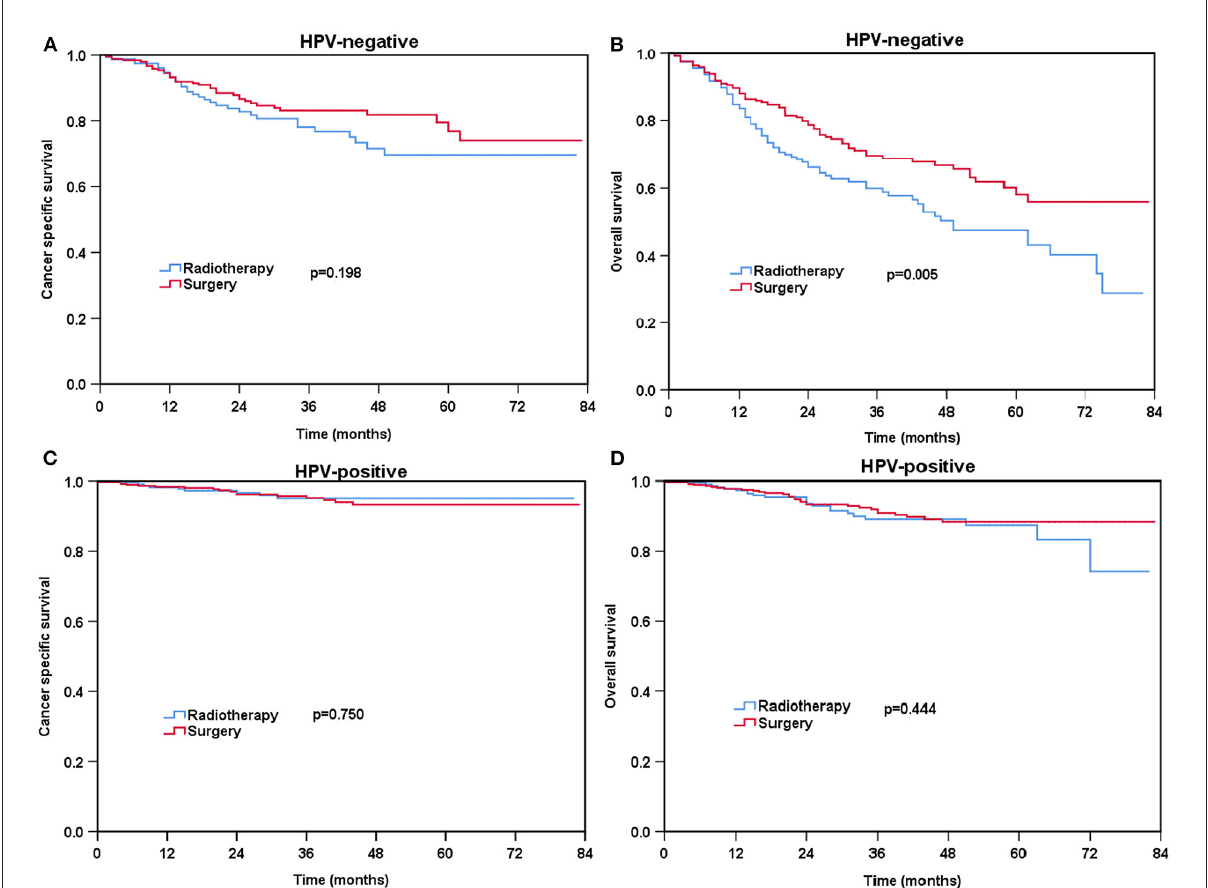
FIGURE3 Kaplan-Meier plots of cancer-specific survival (A) and overall survival (B) for HPV-negative patients and cancer-specific survival (C) and overall survival (D) for HPV-positive patients before